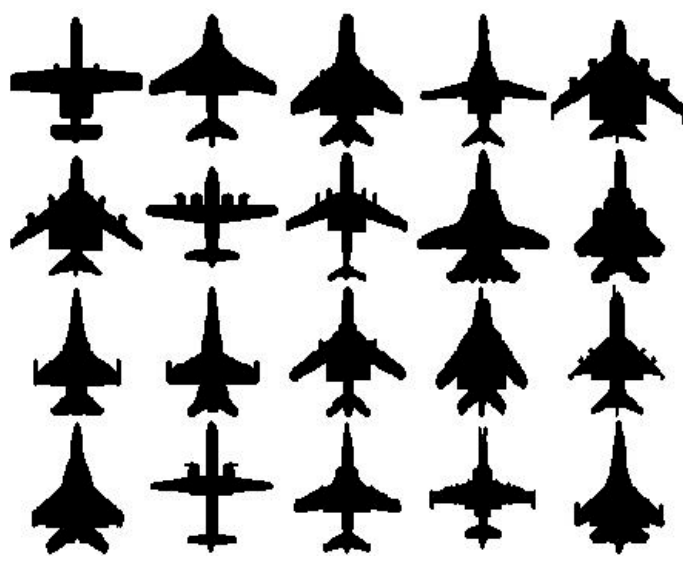
Figure 2. The 2D aircraft dataset.